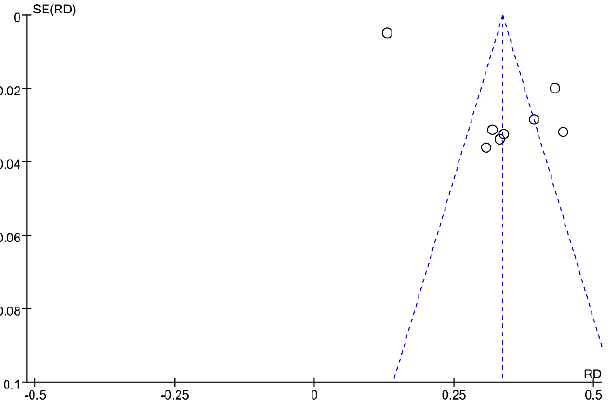
Figure 3. Funnel plot of prevalence estimates of postpartum depressive symptoms.